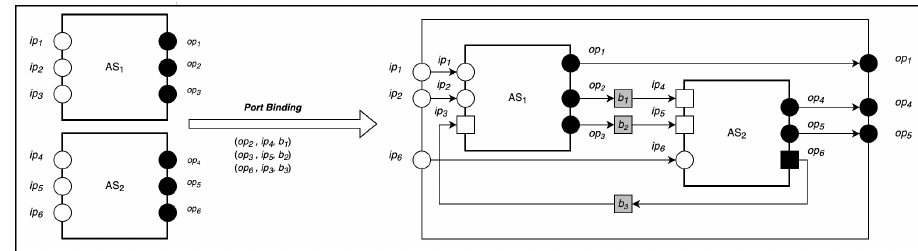
Figure 5. Port-Binding Composition.